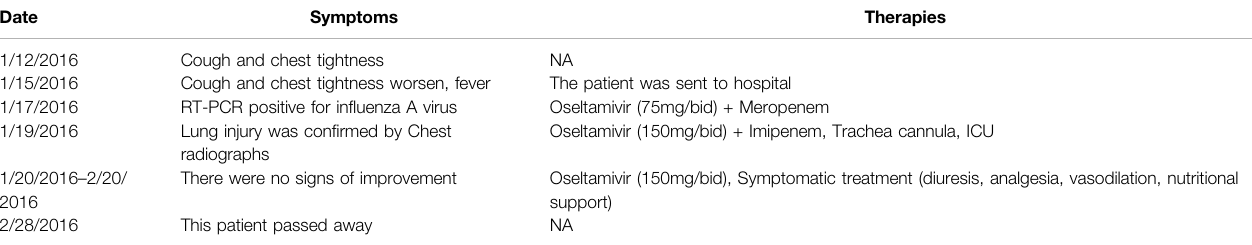
TABLE 1 | The clinical symptoms and therapeutic schedule of this patient.